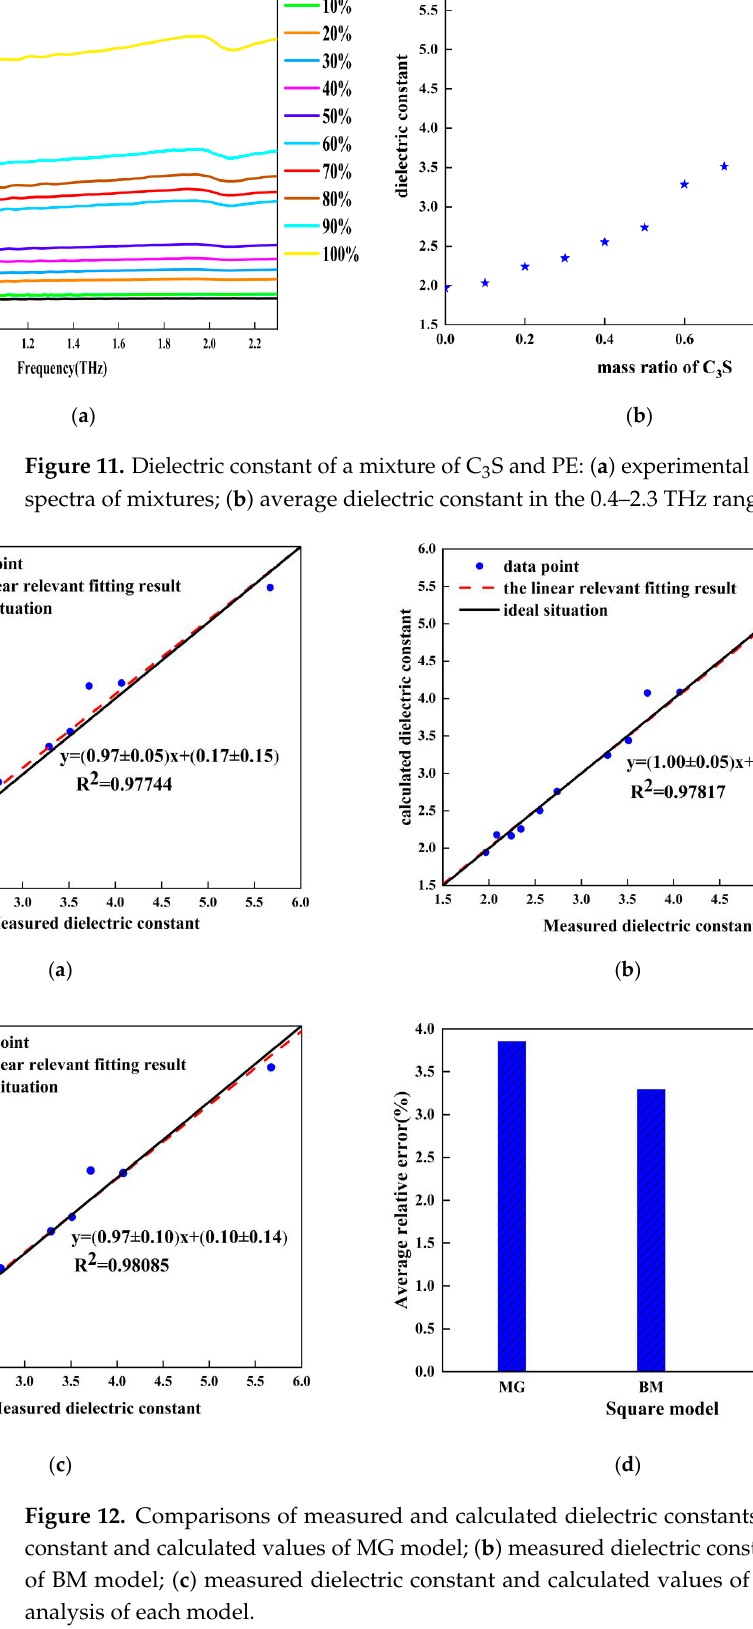
Figure 10. Schematic drawing of three-phase sample.